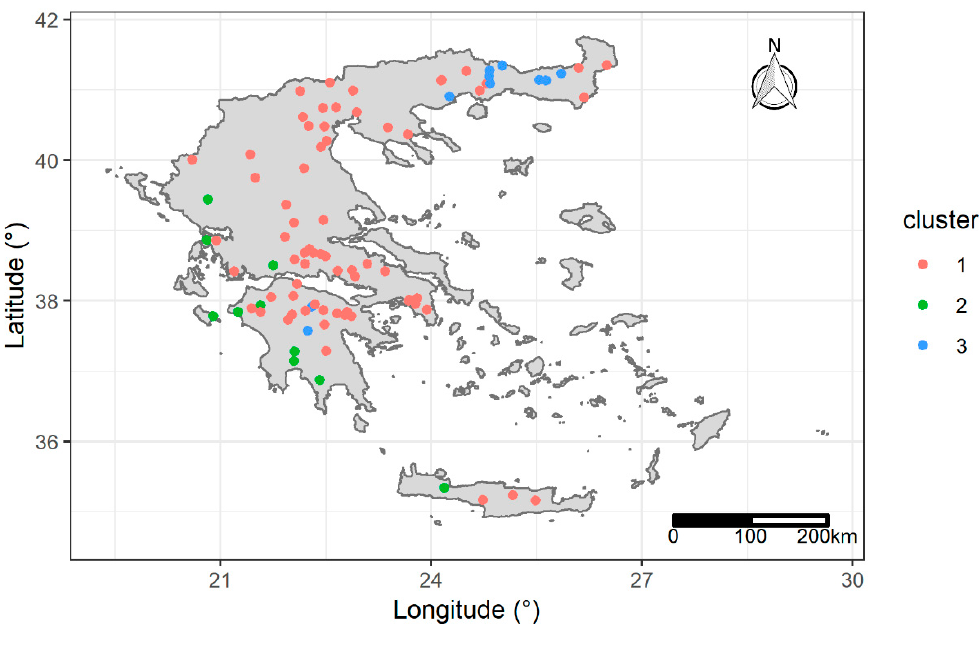
Figure 6. The above plot presents the frequency among all 30 indices used for the determination of the optimal number of clusters.